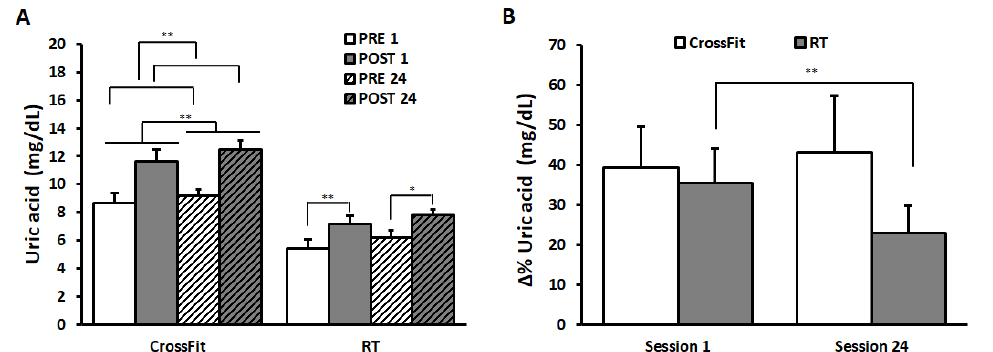
Figure 4. Uric acid values and ∆ %uric acid. Uric acid values (panel ( A )) of CrossFit ® group (left) and RT group (right) before (PRE) and after (POST) the first training session (PRE 1, POST 1) and the last training session (PRE 24, POST 24). ∆ % Uric acid (panel ( B )) of CrossFit ® group (left) and RT group (right) after the first training session (SESSION 1) and the last training session (SESSION 24). Data are presented as means ± standard error. * p < 0.05; ** p < 0.01.